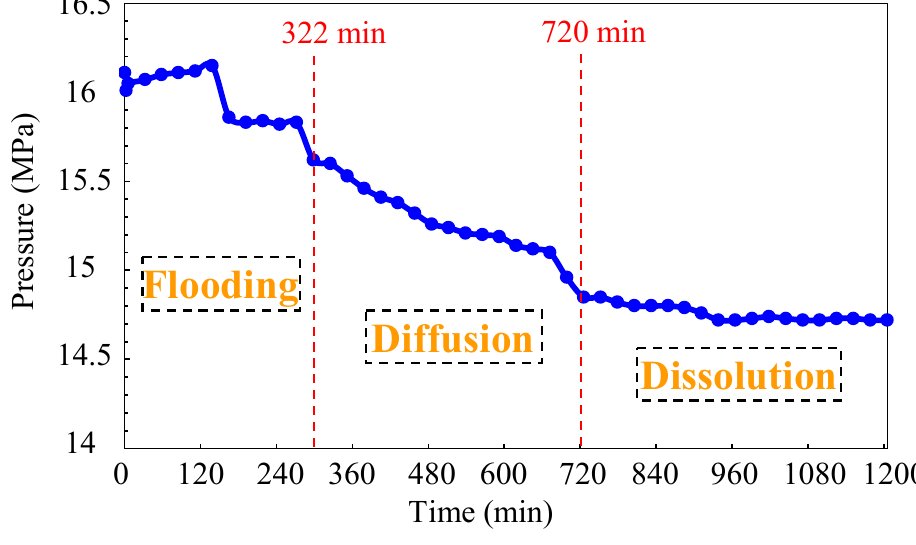
Figure 4. Pressure dynamic curve during the soaking of case one. Figure 5 shows the pressure dynamic curve during the soaking process of case two (CO 2 huff and puff assisted by pumping production and water injection disturbance). The phase before 98 min was the pumping production period, the pumping production was a process of forced oil extraction through pumping energy and increasing production intensity. In the experiment, a large production pressure difference (14 MPa) was set for the transfer pump, and the valve was opened by controlling the pump. The pressure drop in the initial stage of the pumping process decreased greatly, and then slowed down slightly, and the pressure drop increased further at the end of the pumping process. The phase of 98–530 min was the water injection disturbance period, ten disturbance rounds were set, the upper limit of the disturbance amplitude was 16 MPa and the lower limit was controlled to the pressure when CO 2 just overflowed the wellhead boundary, which ensured the maximum disturbance amplitude. The lower limit pressure after each disturbance round was recorded, and the average lower limit pressure of water injection disturbance was 10.743 MPa. Due to the tightness of the reservoir, the pressure rose rapidly during the water injection period, which provided a strong boost to the CO 2 injected in the early stage, so that it could continuously interact with the crude oil and accelerate the pressure propagation. After 530 min, it was a conventional soaking process. Compared with case one, the initial soaking pressure was relatively stable, and the final pressure was stable at 14.92 MPa due to the subsequent decrease in CO 2 dissolution and diffusion